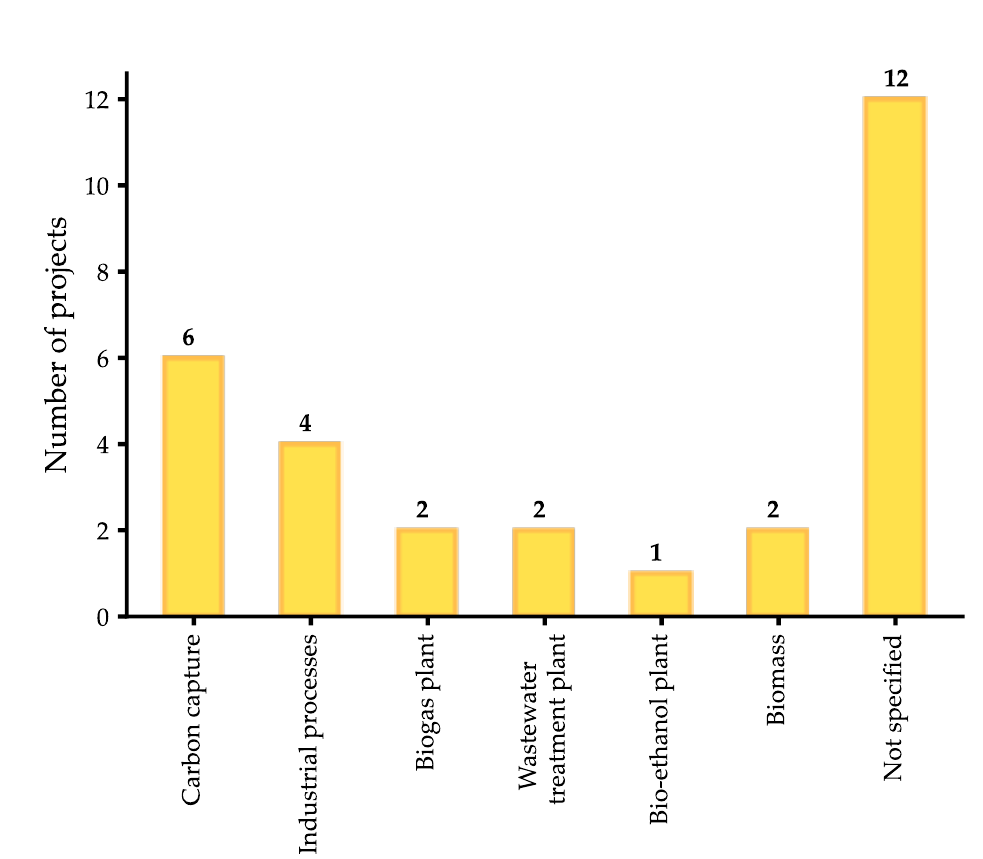
Figure 15. Number of projects per carbon dioxide source.